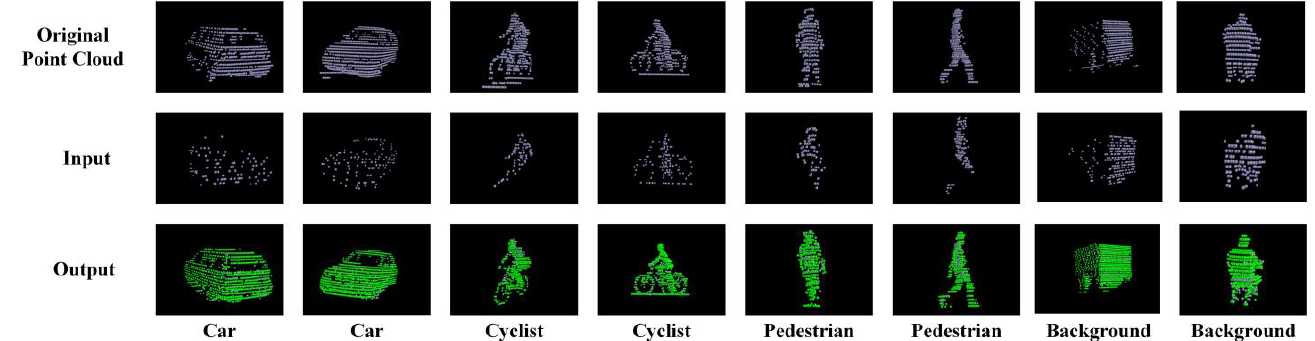
Figure 8. Test set reconstruction visualization. The first row is the original point cloud. The second row is the subset of point clouds after PC-Mask, which is used as the input of PCMAE. The third row is the reconstruction result of PCMAE.